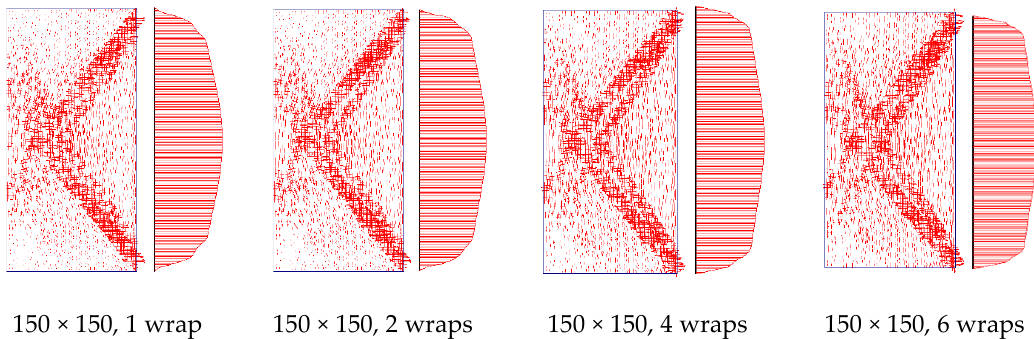
Figure 5. Half cross-section of the 150 mm × 150 mm cylinder with localized failure and the FRP wrap hoop strain profile at peak FRP strain = 1.5%.